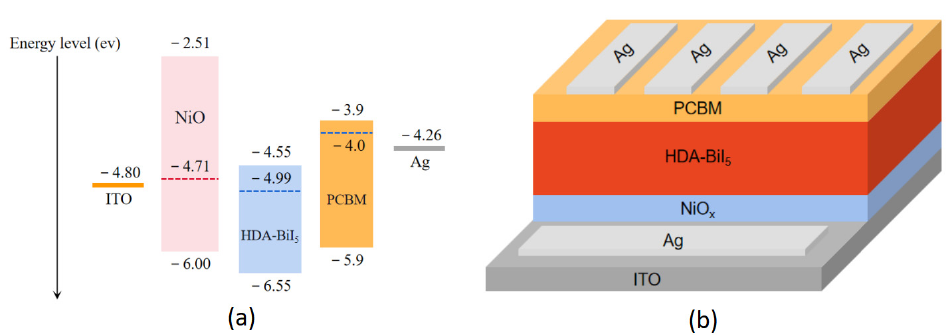
Figure 1. ( a ) Schematic diagram of work function of each functional layer material; ( b ) structure diagram of ITO/NiO x /HDA-BiI 5 //PCBM/Ag inverted device.